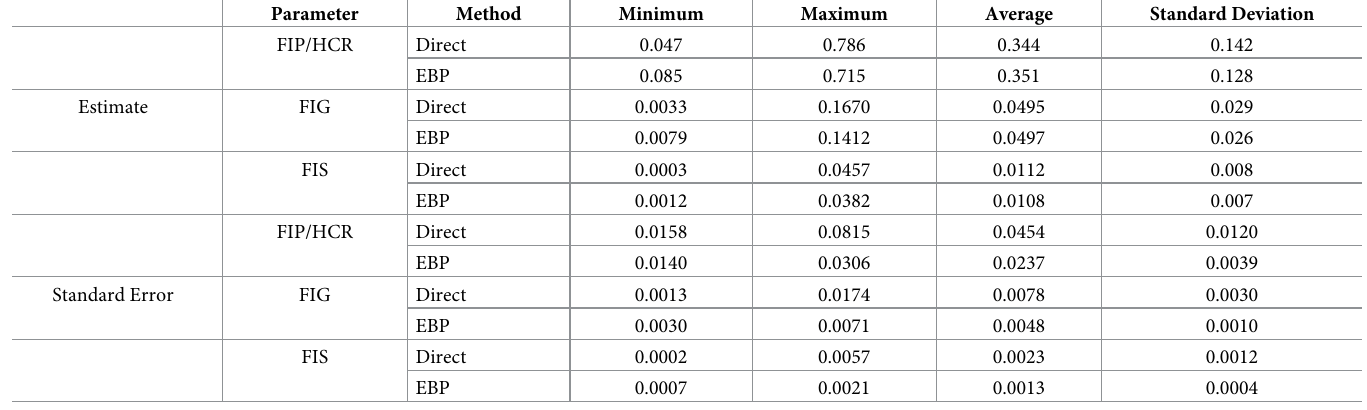
Table 4. Summary statistics of food insecurity